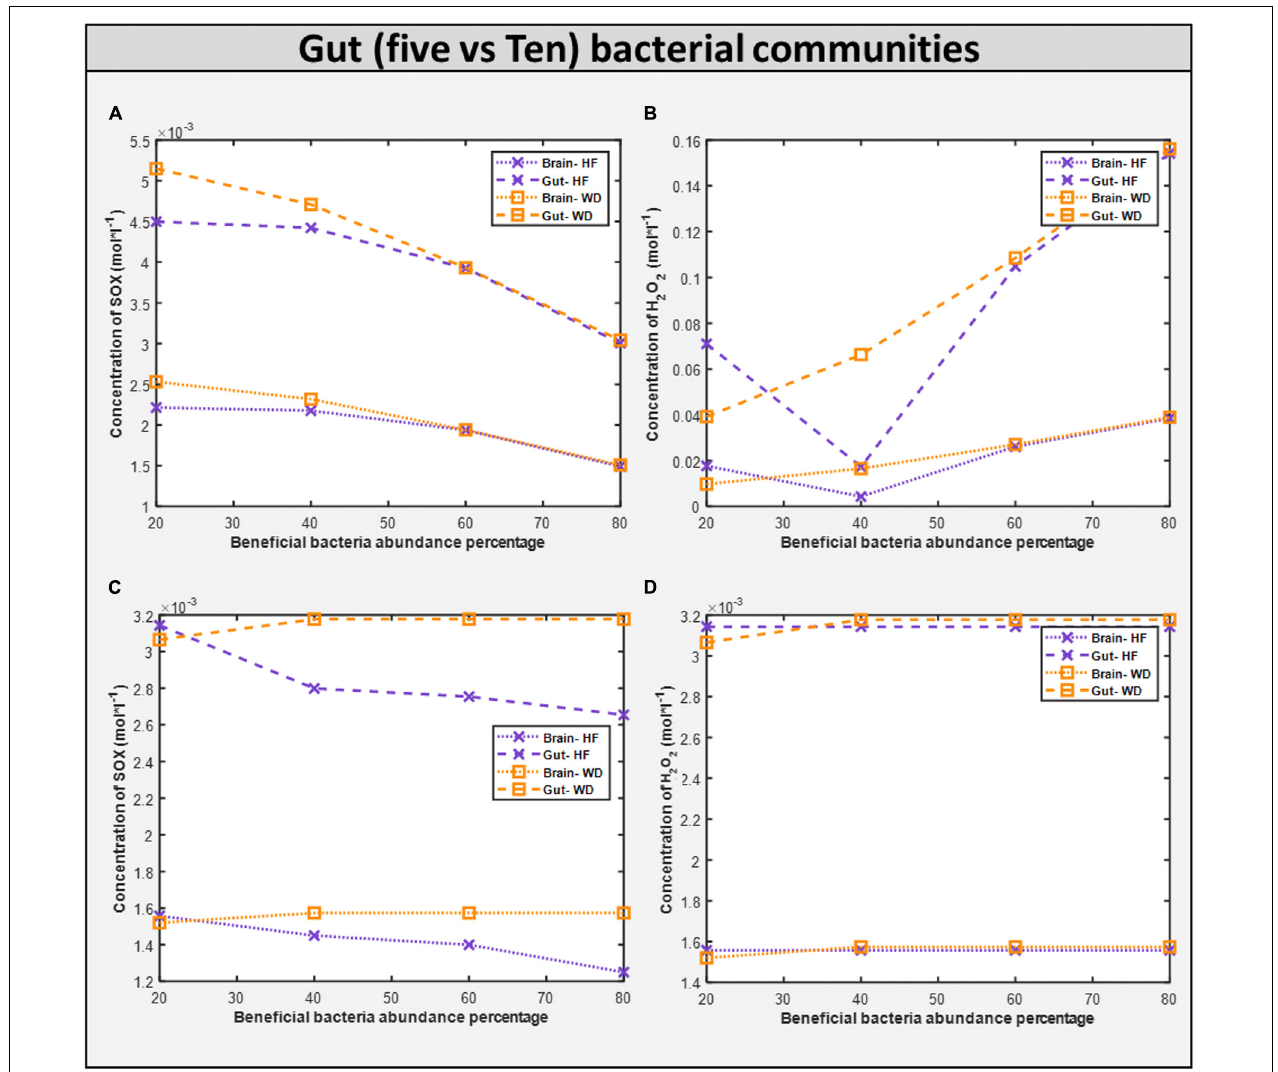
FIGURE 11 | Comparison of toxins (H 2 O 2 and O 2 S) in five vs ten bacterial gut representative model and toxins in corresponding brain model. (A) SOX concentration generated in five microbial community. (B) H 2 O 2 concentration generated in five microbial community. (C) SOX concentration generated in ten microbial community. (D) H 2 O 2 concentration generated in five microbial